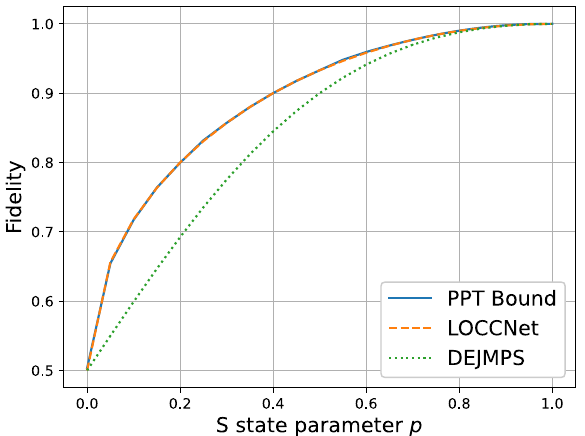
Fig. 3 Fidelity achieved by distillation protocols for two copies of some S state. The orange dashed line depicts the performance of the protocol learned by LOCCNet, which outperforms the DEJMPS protocol (green dotted). Also, the learned protocol is near optimal in the sense that its line almost aligns with the PPT bound (blue solid).